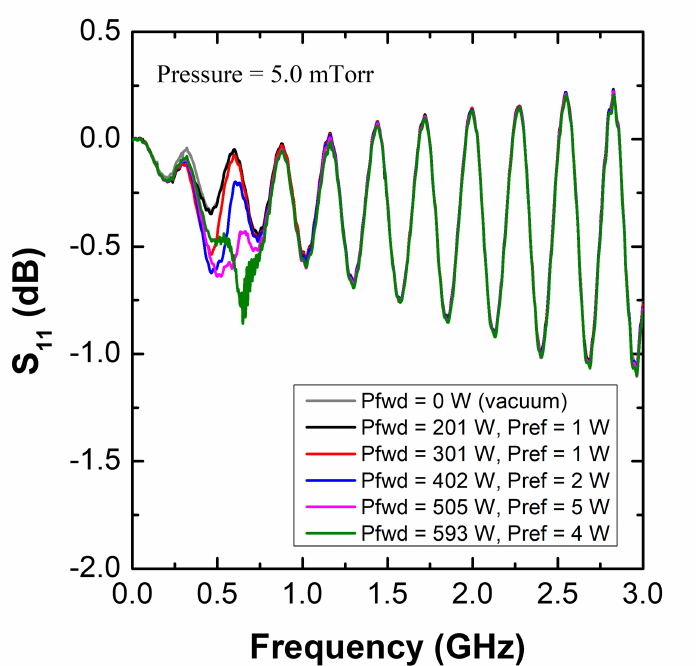
Figure 7. S 11 spectra of the MOLE probe with various rf powers at a pressure of 5.0